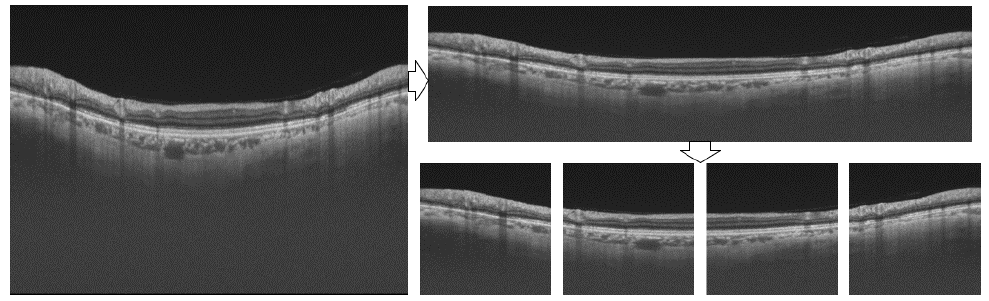
Figure 4. Image pre-processing